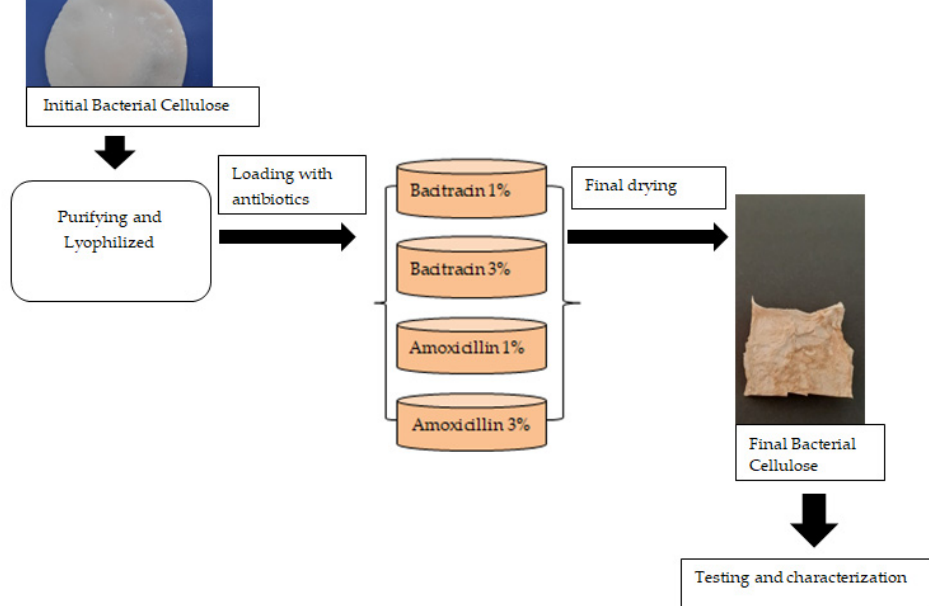
Figure 13. The technological process flowchart for manufacturing bacterial cellulose membranes loaded with bacitracin and amoxicillin.